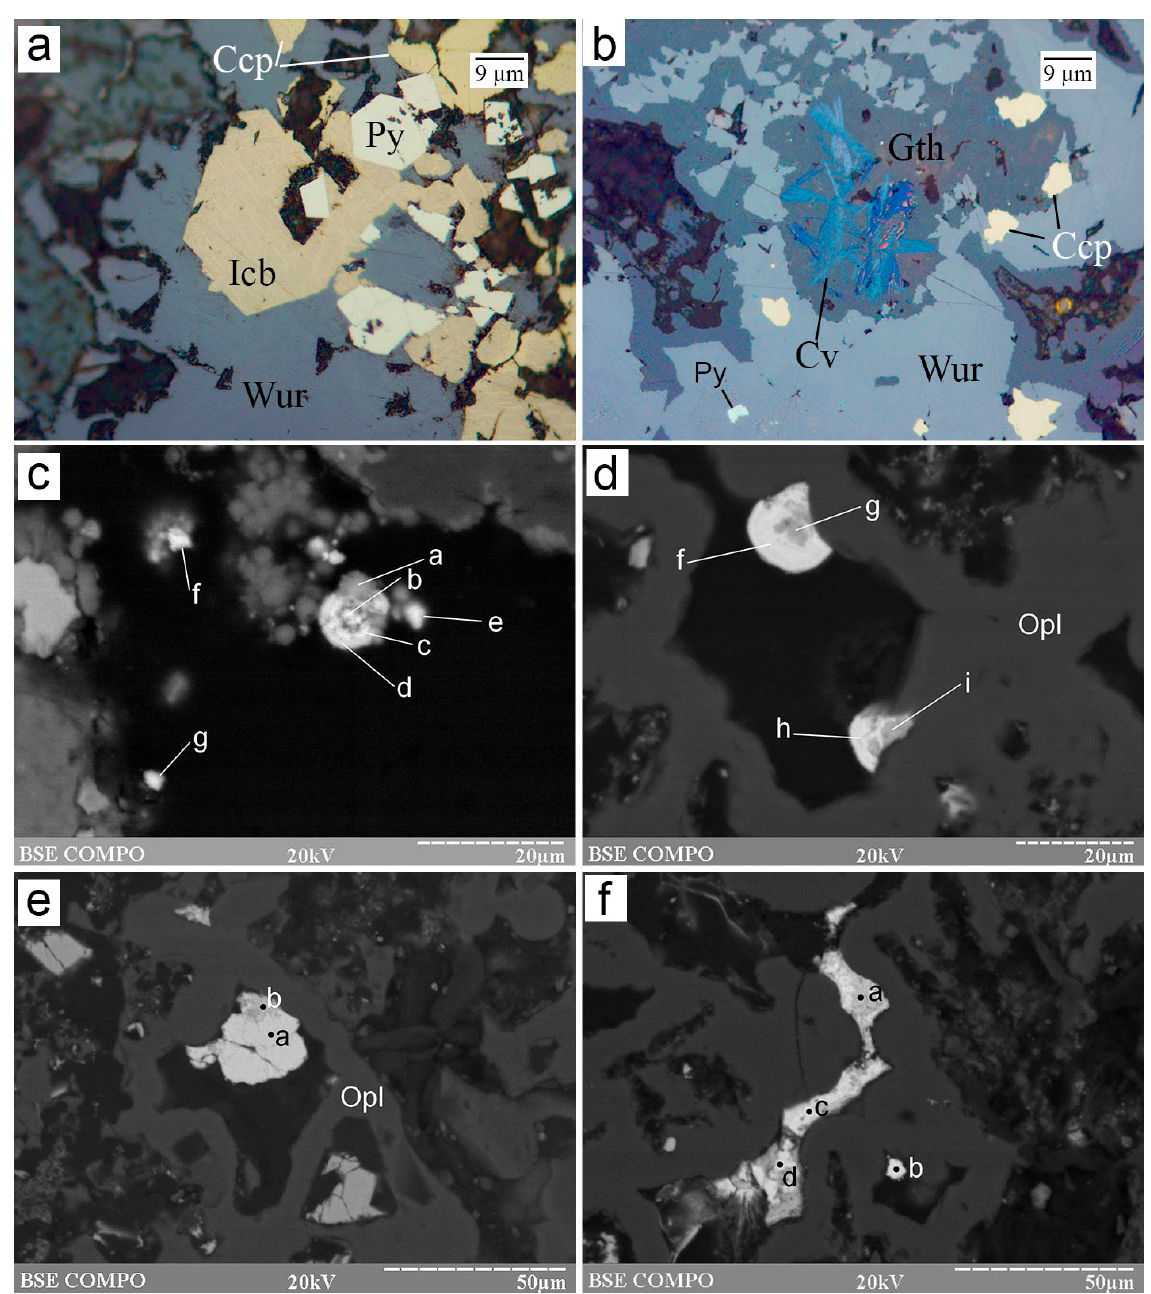
Figure 7. Morphology of Cu–Fe and Cu sulfides from the Irinovskoe HSF: ( a ) Euhedral isocubanite (Icb) and pyrite crystals overgrown by wurtzite; ( b ) Acicular covellite crystals in Fe-oxyhydroxides, which replace wurtzite; ( c ) Spherules of Ag- and Cd-bearing covellite (point a), Cu- and Cd-bearing acanthite (points b, c and f) and an Ag- and Cu-bearing CdS phase (points d, e and g); ( d ) Spherules of Ag- and Sb-bearing covellite (points g and i) and As-bearing Cu–Ag–Sb sulfosalt (“stephanite”) (points h and f); ( e ) An intergrowth of hexagonal-shaped crystal of Ag-rich Sb-bearing Cu sulfide (point b) replaced by Cu-bearing Ag–Sb sulfosalt (“pyrargyrite”) (point a); ( f ) A veinlet of Ag-rich Sb-bearing covellite (point a) replaced by Cu-bearing Ag–Sb sulfosalt (“argentotetrahedrite-Zn”) (points b, c and d) in opal. Images: a , b , reflected light; c–f , BSE image. Sample numbers: 241-2/2-5 ( a – c ), 241 ( d – f ).